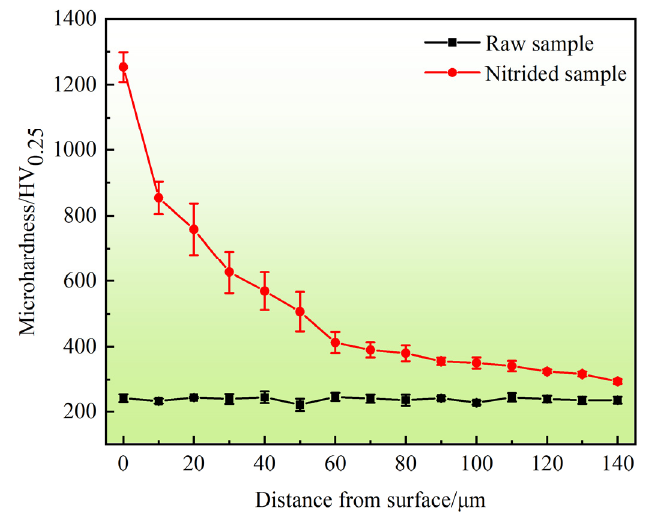
Figure 2. Cross section hardness distribution of the raw and nitrided samples.